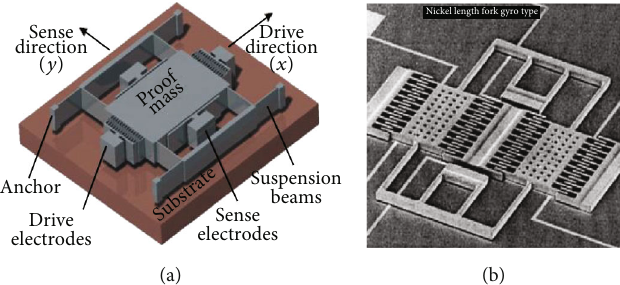
Figure 1: (a) A MEMS vibratory gyroscope (reproduced from [1]). (b) The fi rst gyroscope developed by Draper Lab of MIT (courtesy of [2]).